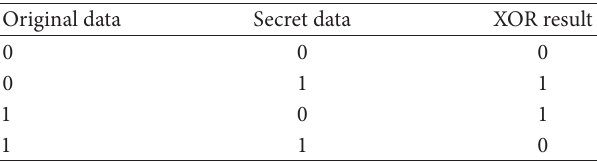
Table 1: XOR based matrix used in the proposed scheme. Original